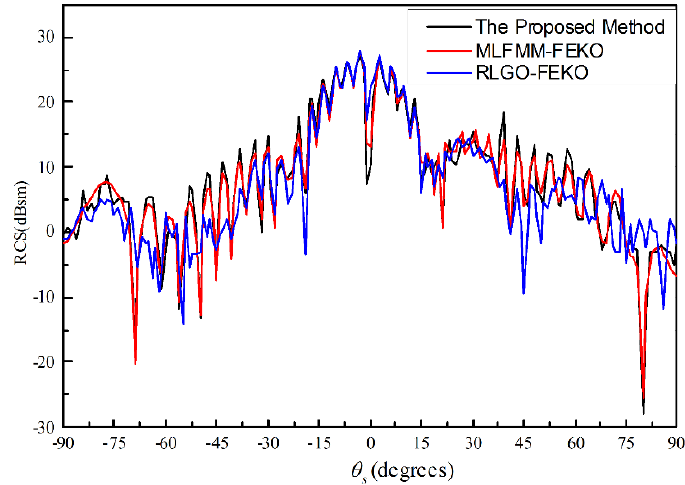
Figure 3. The monostatic scattering from two missile − like targets.